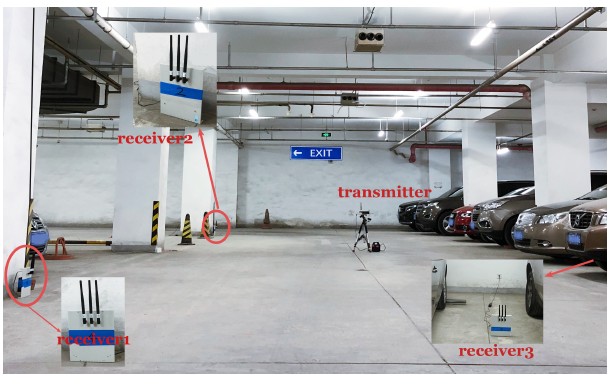
Figure 13. Experimental environments of the complex garage.